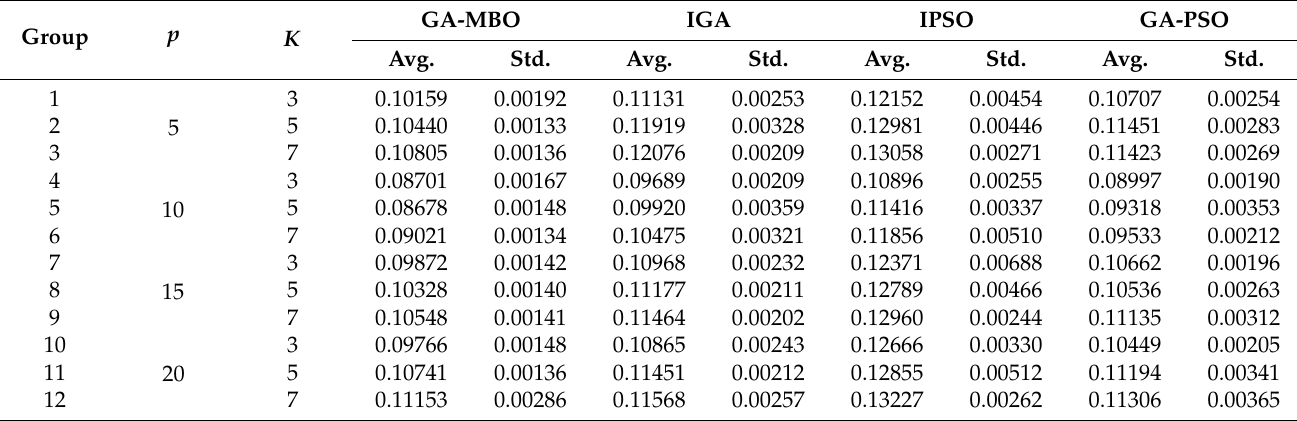
Table 6. Comparison results of four